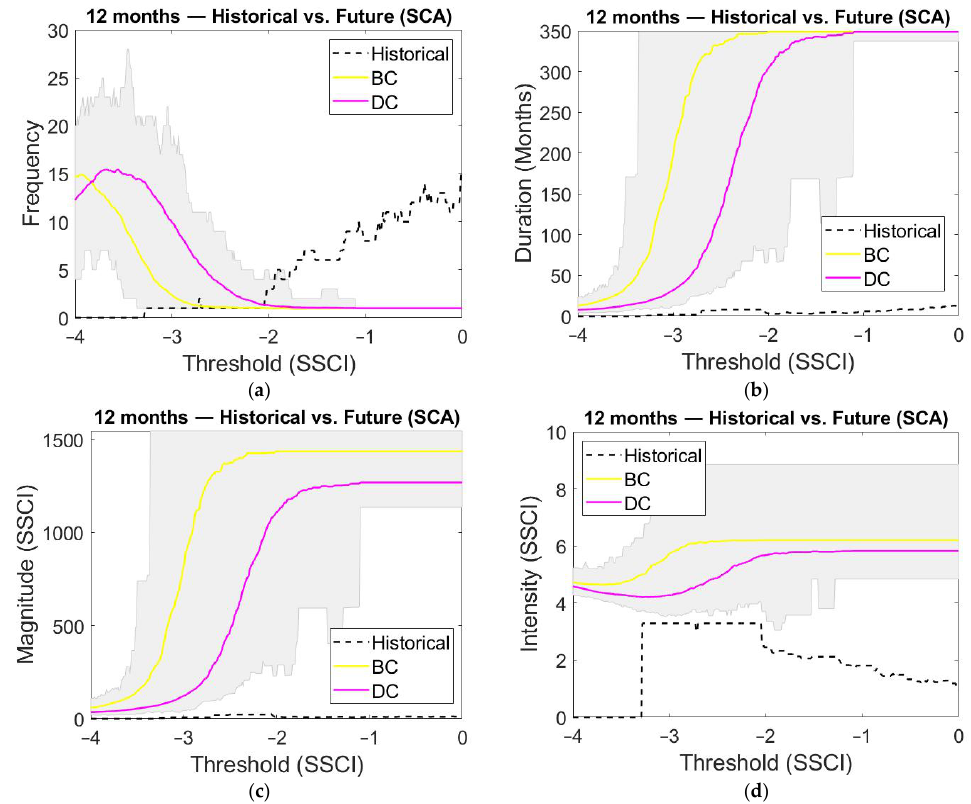
Figure A7. Historical and future meteorological drought ( a ) frequency; ( b ) mean duration; ( c ) mean magnitude; ( d ) mean intensity derived from SPI for the 12 months temporal-aggregation scale (SPREAD and STEAD database). Historical and future meteorological drought ( e ) frequency; ( f ) mean duration; ( g ) mean magnitude; ( h ) mean intensity derived from SPEI for the 12 months tem- poral-aggregation scale (SPREAD and STEAD database).